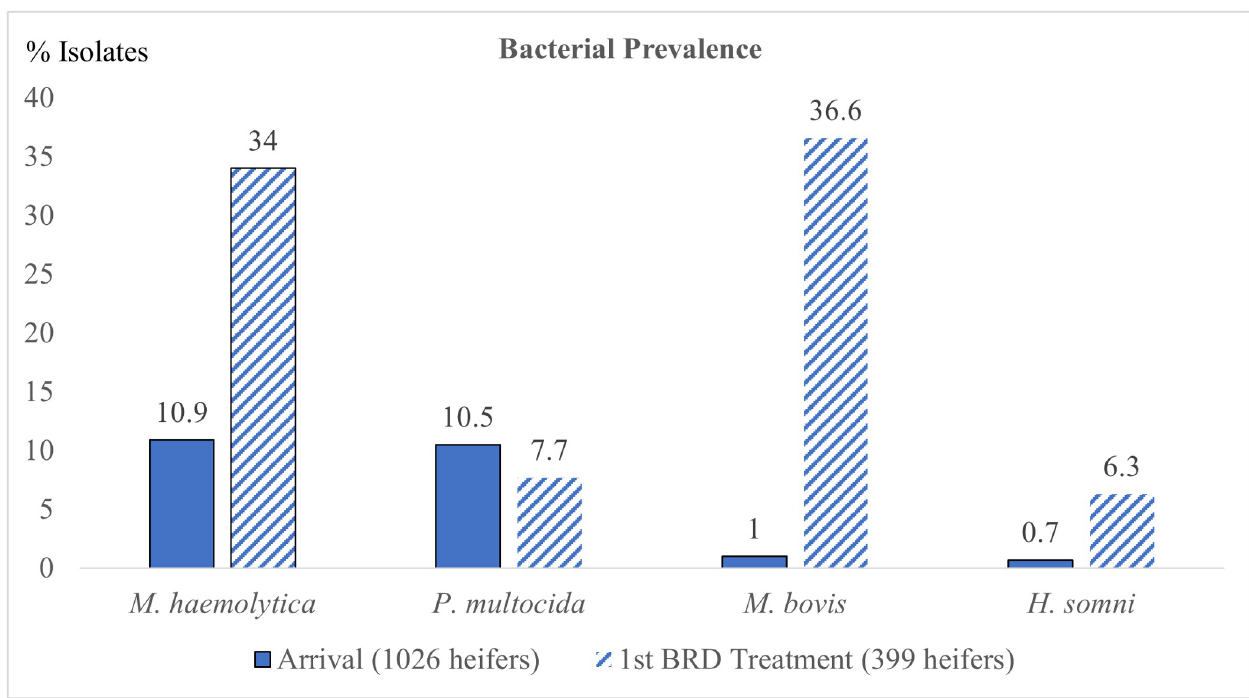
Fig 2. Prevalence of BRD pathogens from DNS in high-risk feeder heifers at day-0 and 1 st BRD-treatment. The y-axis is percent of isolates cultured and the numbers above the columns represent the number of animals with positive isolates.